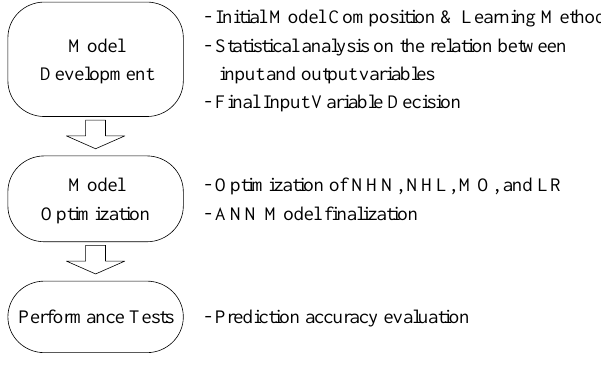
Figure 1. Development process.